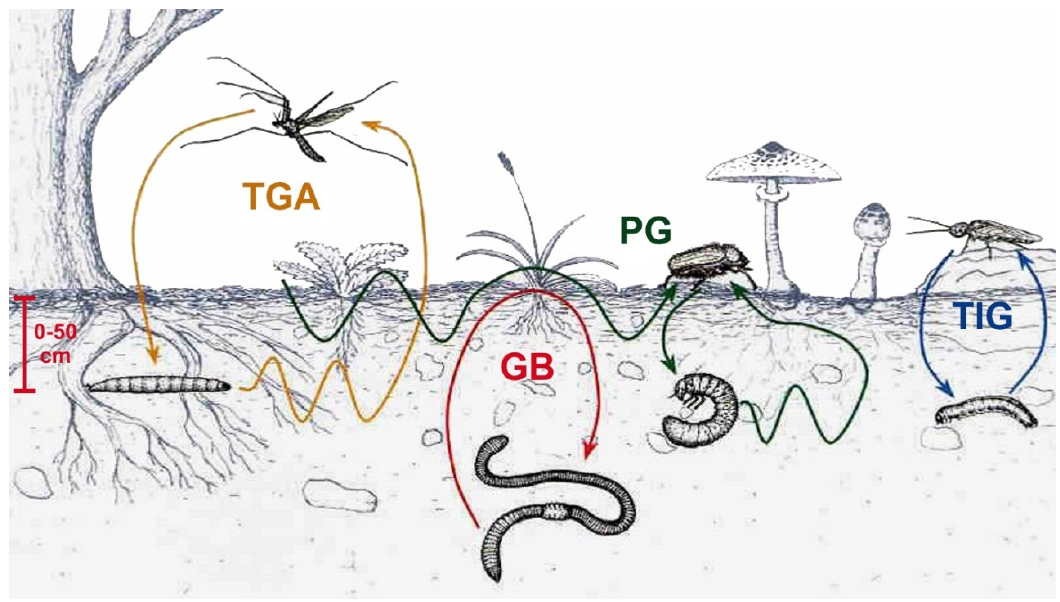
Figure 4. The four functional groups of soil macrofauna: temporary active geophilous (TAG), temporary inactive geophilous (TIG), periodic geophilous (PG), and geobionts (GB).